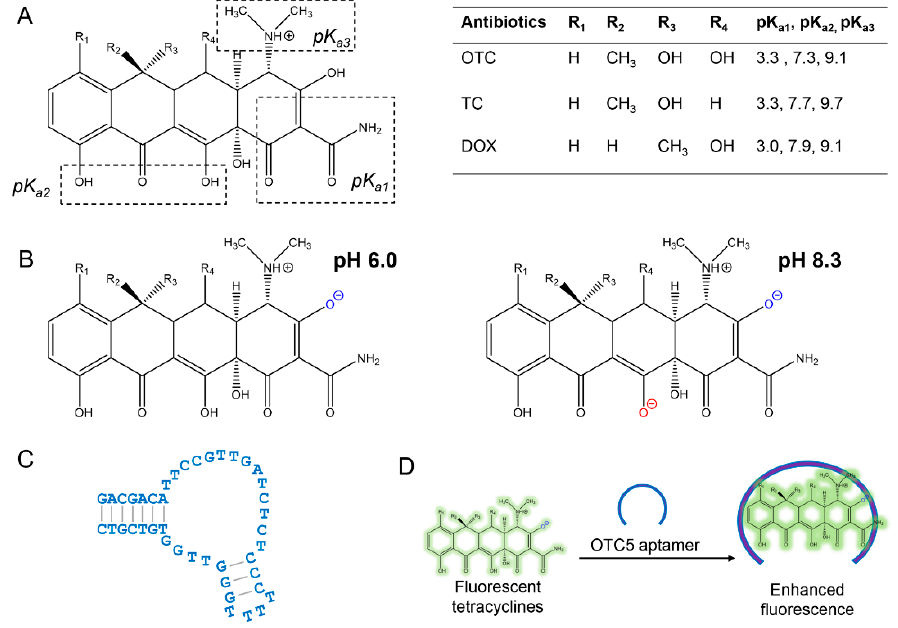
Figure 1. The general structure of the tetracyclines with their respective p K a values. ( A ) p K a values and structures adapted from ref. [16,36]. ( B ) The structure of the tetracyclines at pH 6.0 and pH 8.3. ( C ) The secondary structure of the OTC5 aptamer. ( D ) A cartoon showing the fluorescence enhancement of the tetracyclines upon aptamer binding.